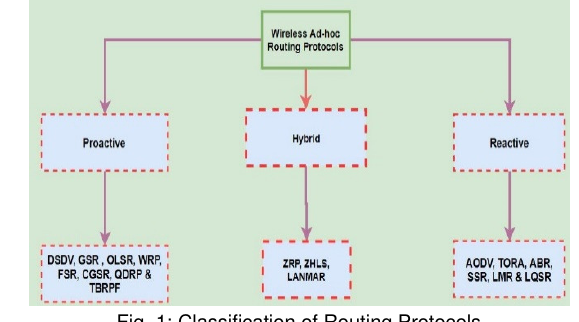
Fig. 1: Classification of Routing